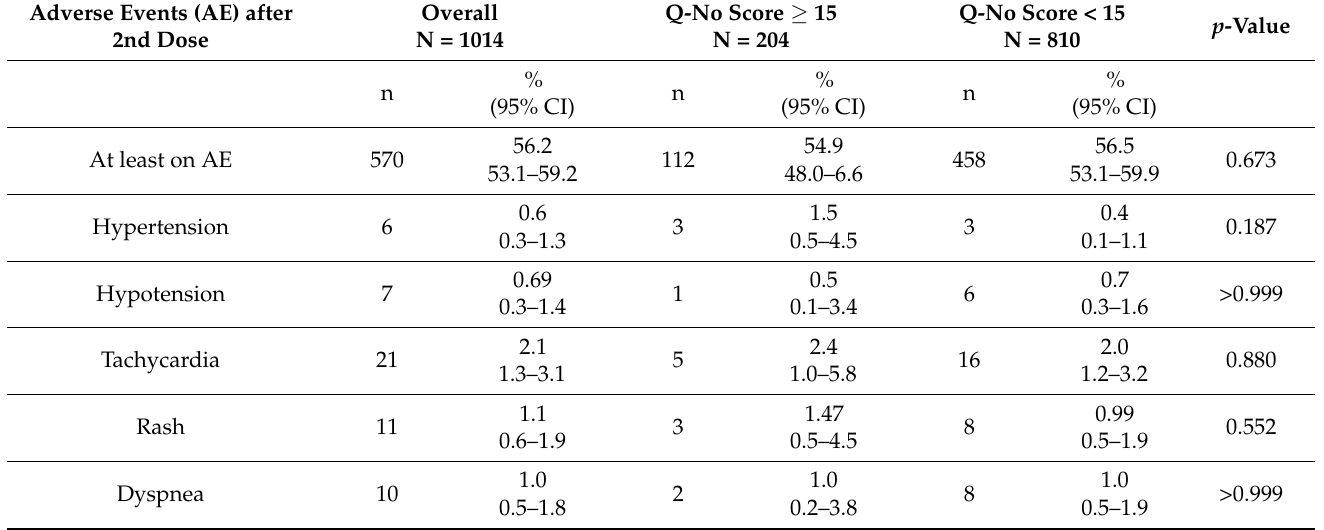
Table 6. Most common reported adverse events after 2nd dose by Q-No